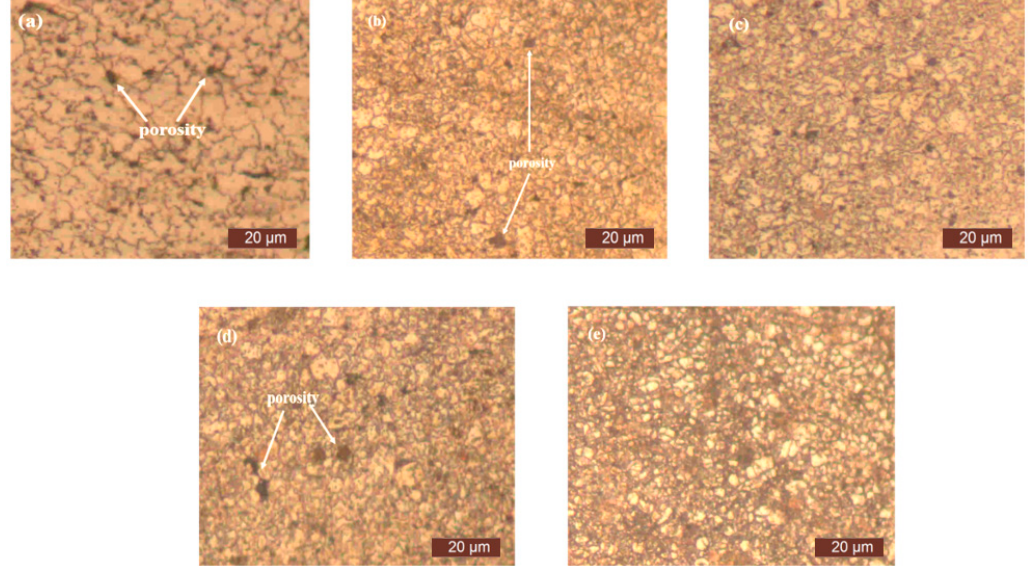
Figure 3. Microstructure of sintered samples ( a ) S1 ( b ) S2 ( c ) S3 ( d ) S4 ( e ) S5.